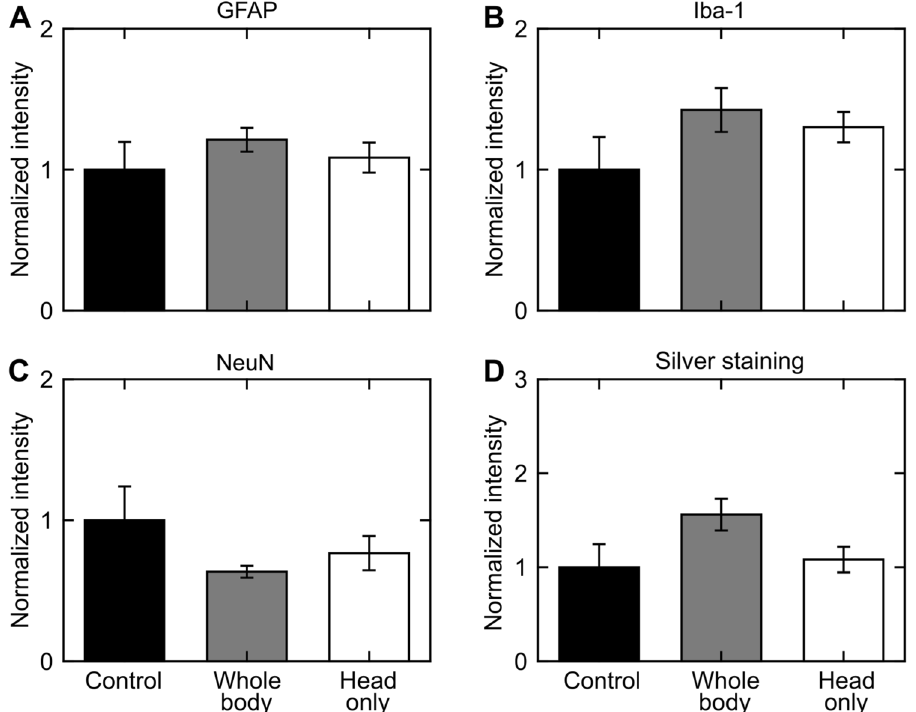
Figure 4. Changes in the rat brain due to whole-body or head-only blast exposure in the direct-mechanism study, as indicated by ( A ) GFAP-positive, ( B ) Iba-1-positive, ( C ) NeuN-positive, and ( D ) silver staining. Asterisks denote statistically significant differences (p < 0.05) between blast-exposed (n = 10) and control (n = 4) groups. The bar heights and vertical line lengths represent the mean and one standard error of the mean (SEM), respectively. We determined per-animal estimates by averaging the values of the 12 coronal brain slices for each animal. For each group, we then determined the mean and SEM using the respective per-animal estimates. Lastly, for each staining assessment, we normalized the data from the blast-exposed groups (i.e., whole-body and head-only) by the data from their respective controls. We normalized the data for presentation purposes only. We conducted all statistical analyses using the raw data with their respective values. We did not find a statistically significant difference in any of the staining assessments between control and blast-exposed